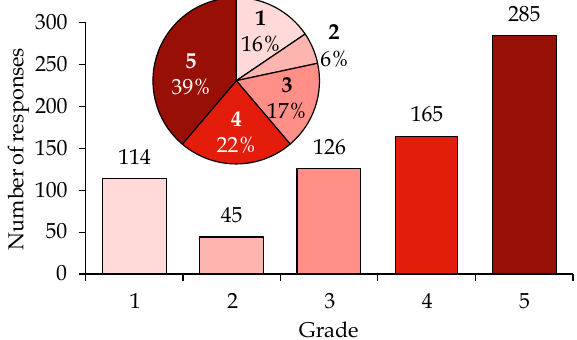
Figure 11. Responses on the degree that lockdown measures against the spread of COVID-19 altered the perception of citizens in regard to urban green areas as a means of improving public health (research question: “How much was your perception about the UGAs affected, regarding the improvement of human public health after (March 2020) the restriction measures (quarantine) for the prevention of spreading COVID ‐ 19?”), (grading scale: 1 = minimum to 5 = maximum).